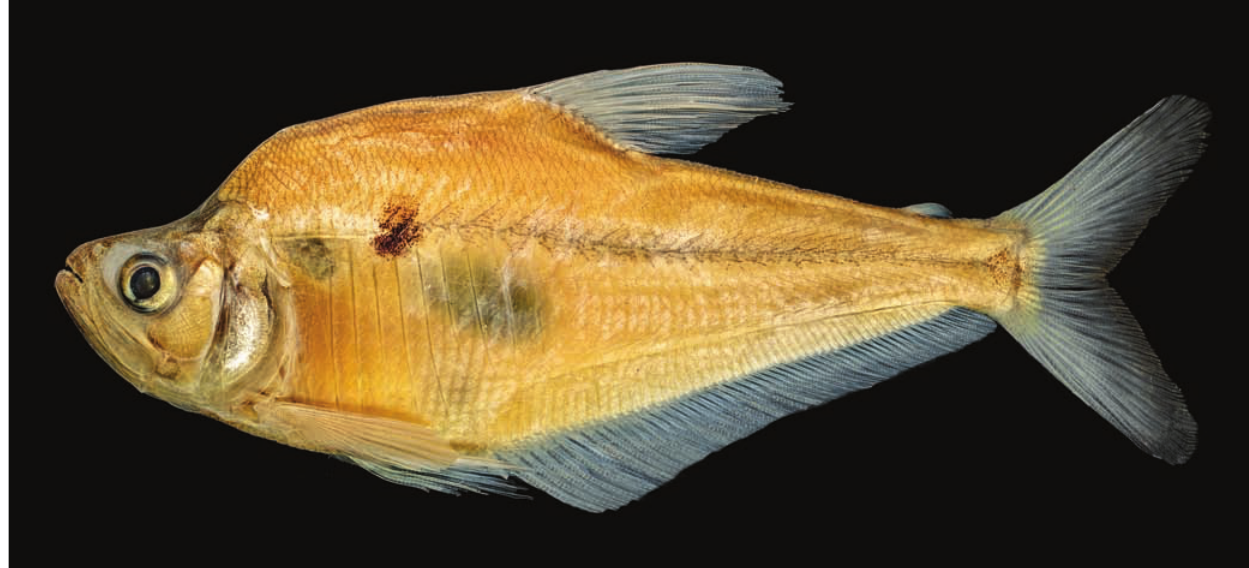
Fig. 19. Charax niger , MZUSP 33427, female, paratype, 113 mm